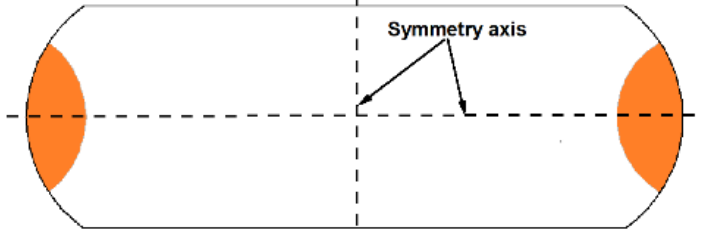
Figure 2. The longitudinal section of the cylindrical specimen after compression: orange—the indentation zone.